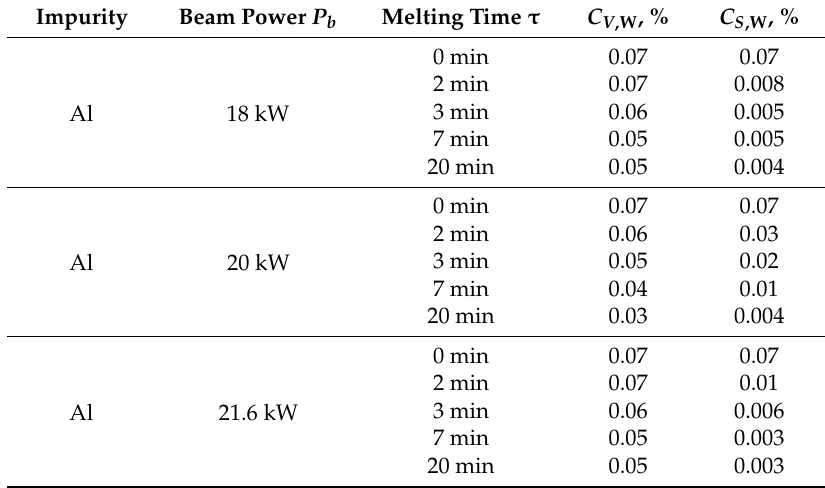
Table 5. Aluminum concentration in the molten volume ( C V ,Al ) and at the top surface of the liquid pool ( C S ,Al ) depending on P b and τ of the e-beam melting of